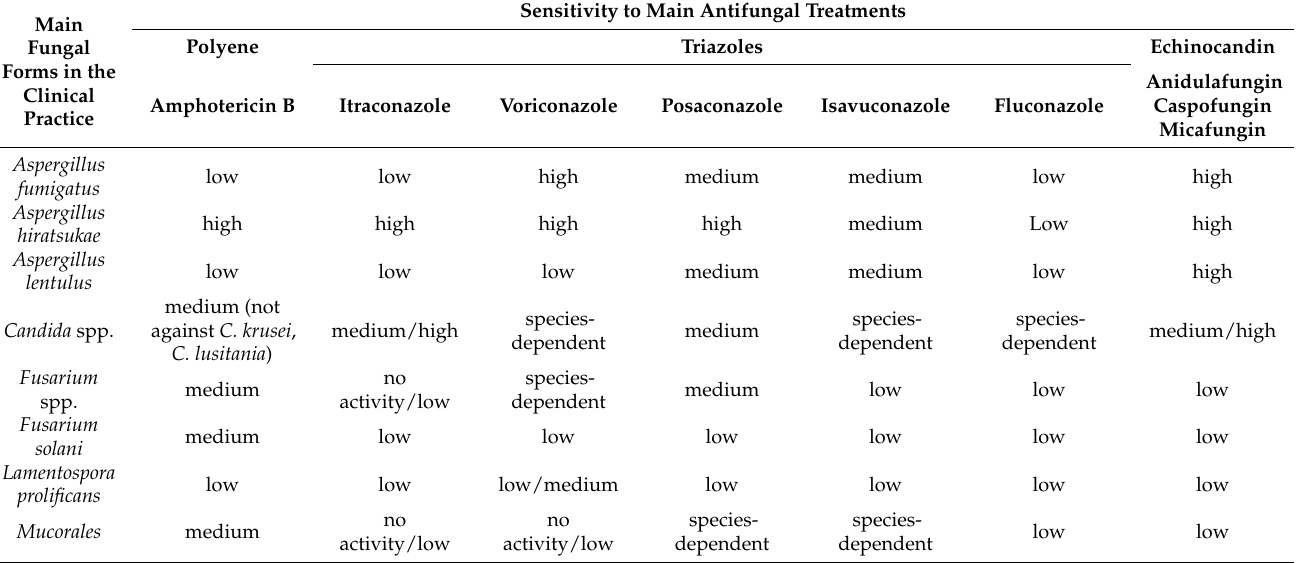
Table 1. Main fungal forms in the clinical practice and sensitivity to antifungal treatments are de- scribed in the table. High: High sensitivity; Medium: Intermediate sensitivity; Low: Low